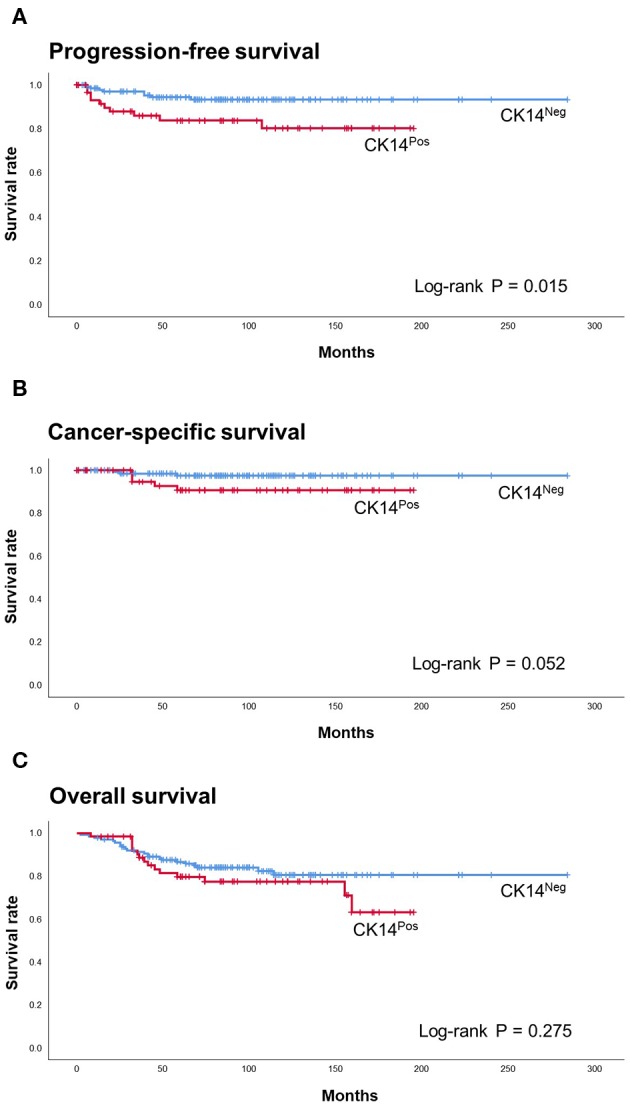
Kaplan-Meier with log-rank test of CK14 IHC staining in PFS (A), CSS (B), and OS (C) of the prognosis cohort.